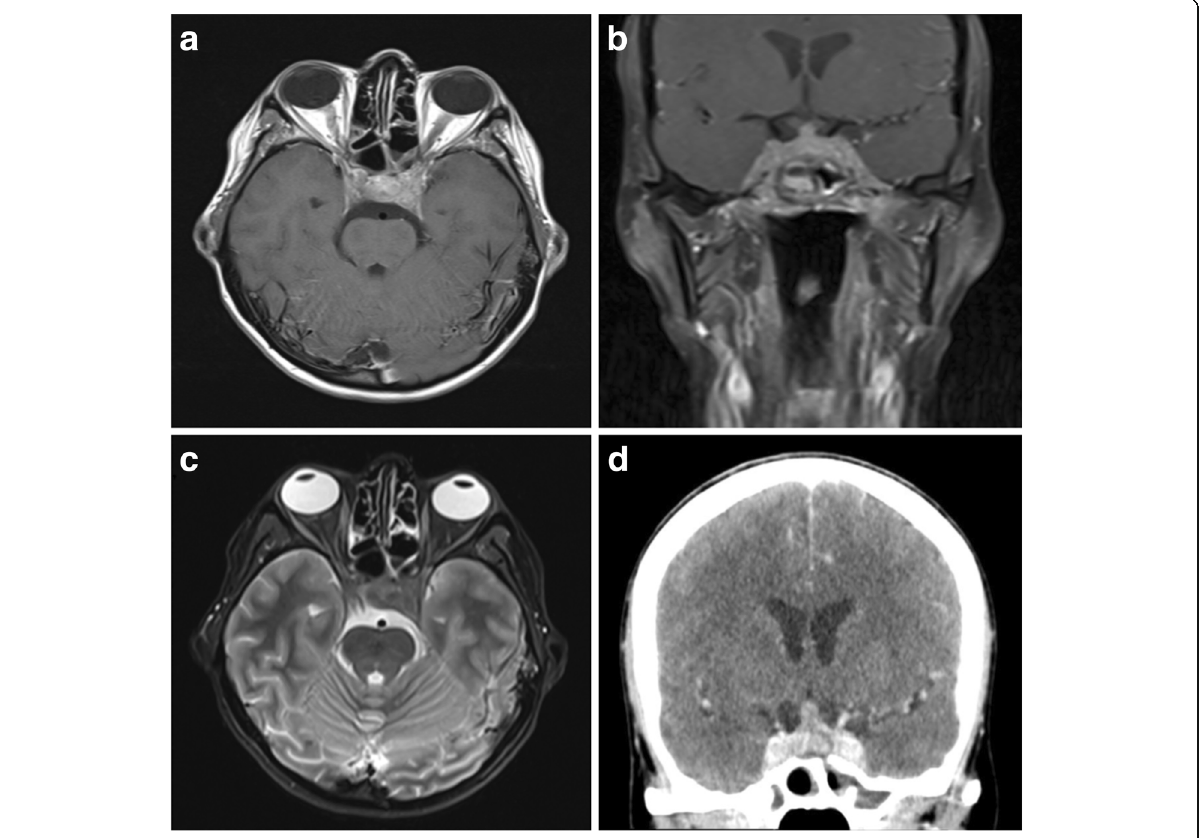
Fig. 12 Granulomatosis with polyangiitis of the skull base. a , b Post-contrast T1-weighted axial and coronal MR images showing enhancing inflammatory soft tissue involving the skull base and cavernous sinuses. There is also inflammatory change within the adjacent sphenoid sinus. c T2-weighted axial image of the same lesion at the level of the cavernous sinuses. d Post-contrast axial CT image again showing avid enhancement within durally based abnormal soft